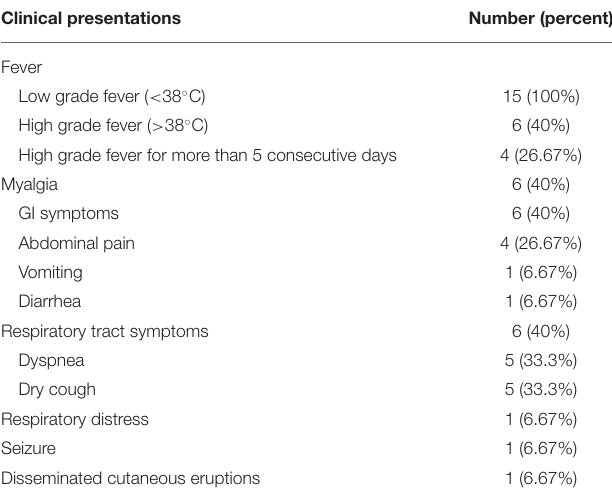
TABLE 1 | Clinical presentations of the 15 evaluated patients with COVID19.